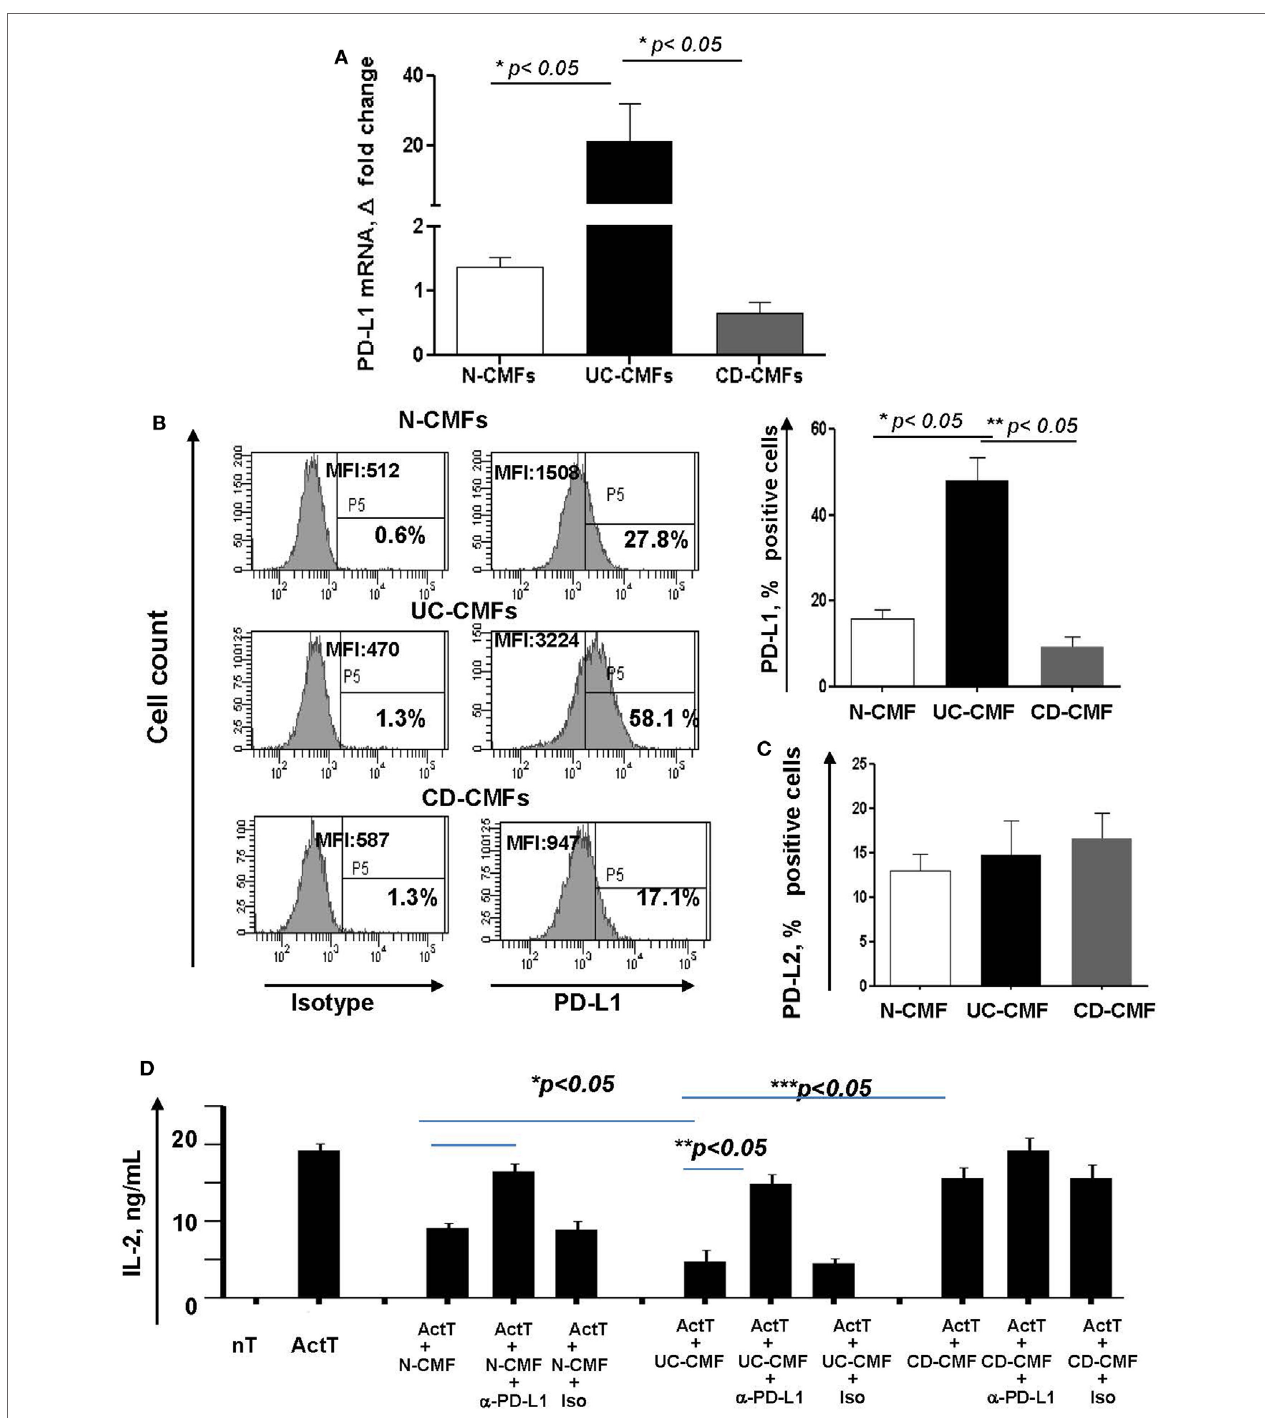
FigUre 4 | An increase in surface programmed death-ligand 1 (PD-L1) by UC-CMFs and a decrease by CD-CMFs modify cell-mediated suppression of IL-2 production byCD3-/CD28-activated CD4 + T cell IL-2 production. (a) PD-L1 mRNA (real-time RT-PCR analysis) and (B) surface protein (flow cytometry analysis) expression was increased in 6–7 days, 90–100% confluent primary cultures of UC-CMFs, but decreased in CD-CMFs when compared to N-CMFs. Representative flow cytometry histogram and summary of the surface PD-L1 expression shown on panel (B) . The means ± SEM are shown, n = 8 per group. (c) PD-L2 surface expression on primary UC-, CD-, and N-CMFs (flow cytometry analysis); the means ± SD are shown, n = 8 per group. (D) CMFs were cocultured with allogeneic CD3-/CD28-preactivated naive CD4 + T cells (Act T cells) at a ratio of 1:2.5 for 72 h in 24-well plates. PD-L1 blocking mAbs (clone MIH1) or isotype controls were added in the concentration 1 µg/ml. IL-2 production was analyzed using singleplex cytokine analysis. The means ± SD are shown, n = 5 allogeneic donor pairs per group, two experimental replicates